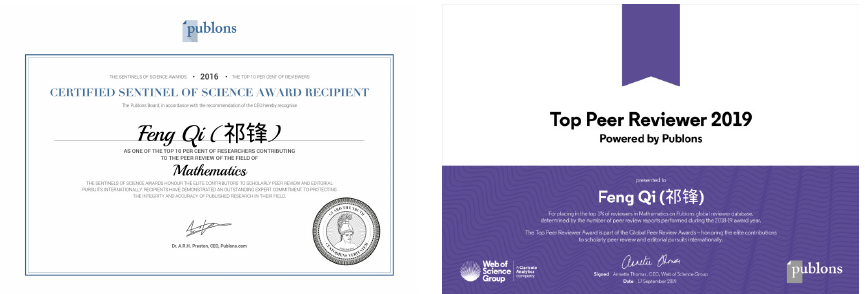
Figure 1. Qi’s Certificates for Top Peer Reviewer powered by Publons in 2016 and